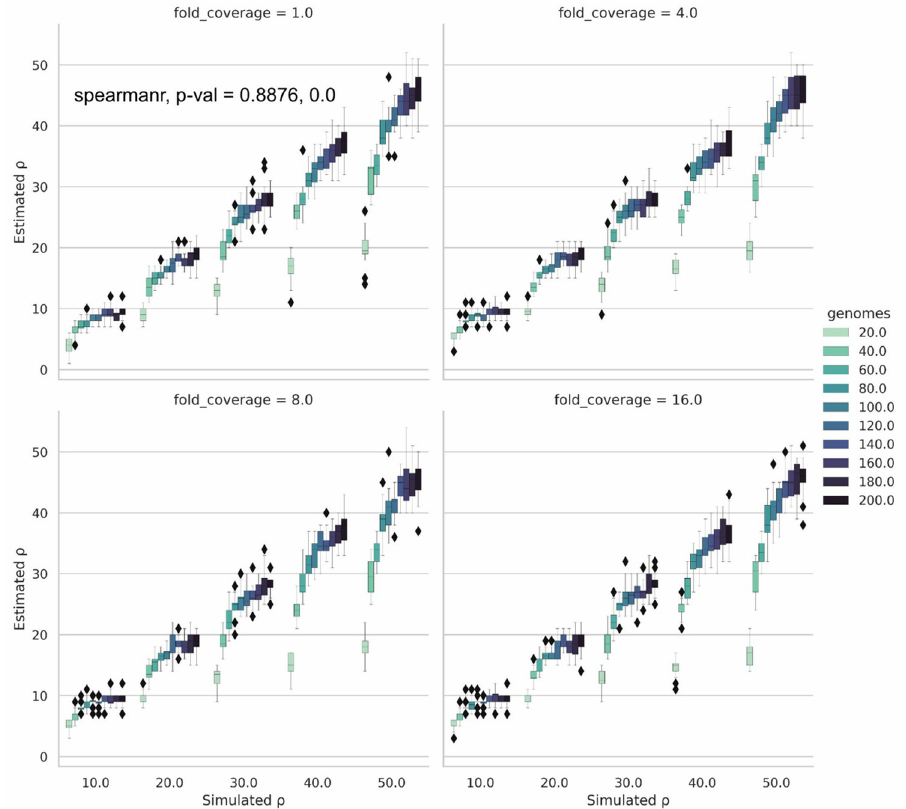
Fig 3. Simulated vs Estimated population recombination rate ( ρ ) results for Rhometa. Results for varying numbers of simulated genomes and fold coverage values for population recombination rates 10.0, 20.0, 30.0, 40.0, 50.0.